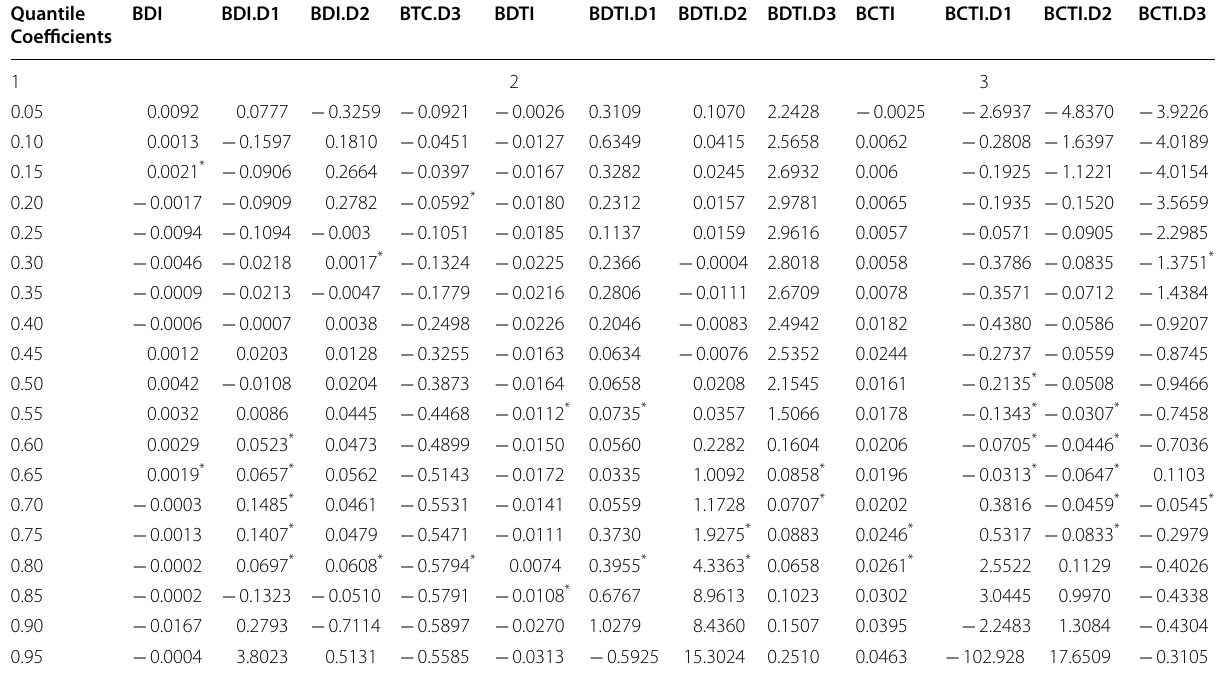
Note: * denotes the significance level. D1, D2, and D3 denote the decomposed data for the short, medium and long run, respectively.